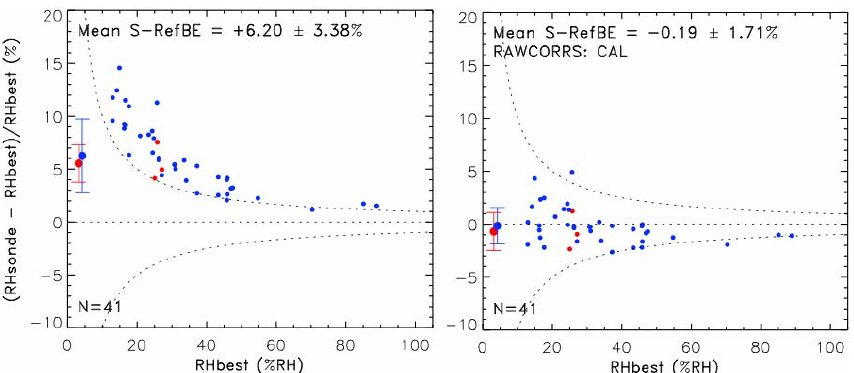
Fig. A2. Percentage difference between RS92 RH measurements and the mean of the 6 THPref probes, shown as a function of RH for the original RS92 measurements (left panel) and after applying the correction for mean calibration bias (right panel). Blue indicates nighttime measurements and red indicates daytime. The curved dashed lines represent a difference of ± 1% RH.